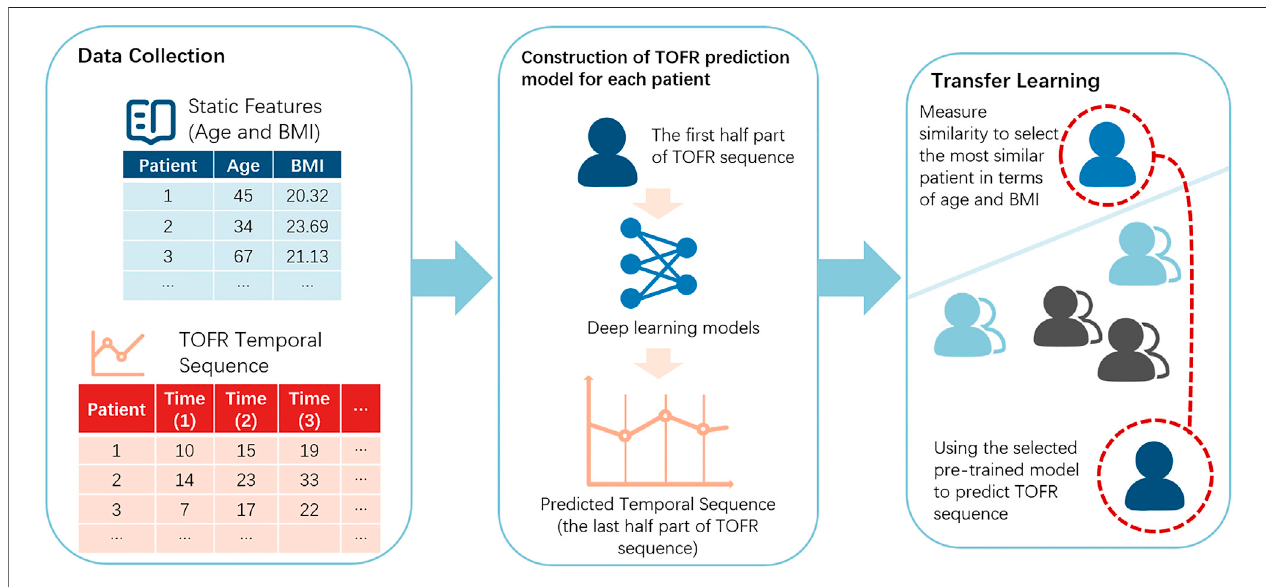
FIGURE 1 | The work fl ow of this